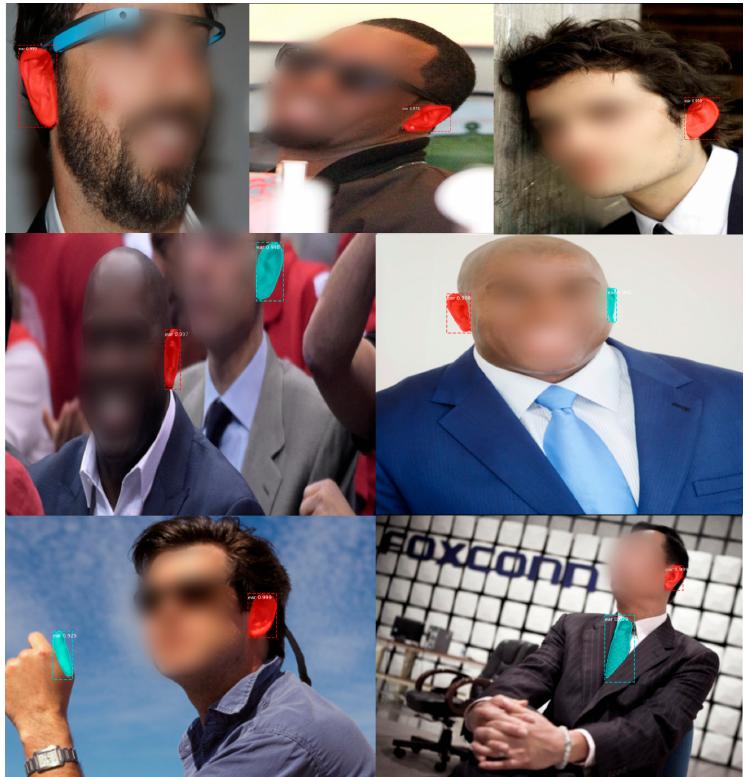
Figure 5. Ear detection using the Mask R-CNN. on the first row, detections of only one object per image, on the second row, it shows detections of two ears from the same person and different people, finally, the last row show also fail